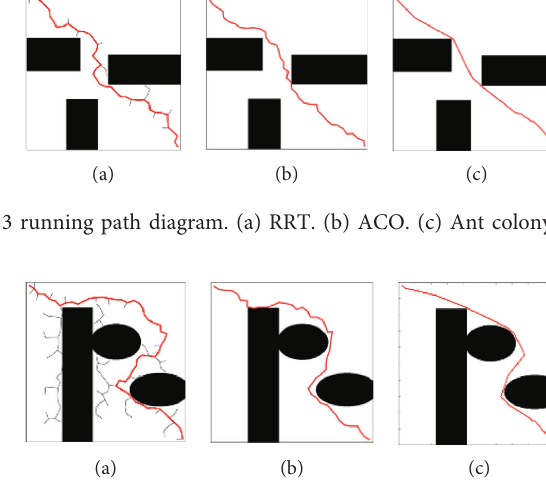
Figure 7: Map 4 running path diagram. (a) RRT. (b) ACO. (c) Ant colony optimization Table 1: The shortest paths of three algorithms under different maps The shortest path